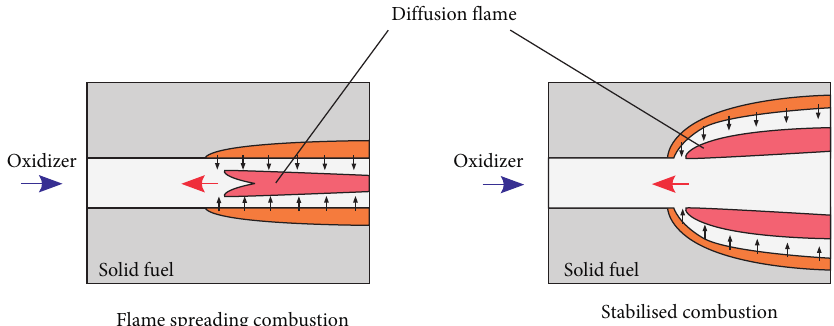
Figure 1: Schematic representation of combustion modes in a narrow fuel